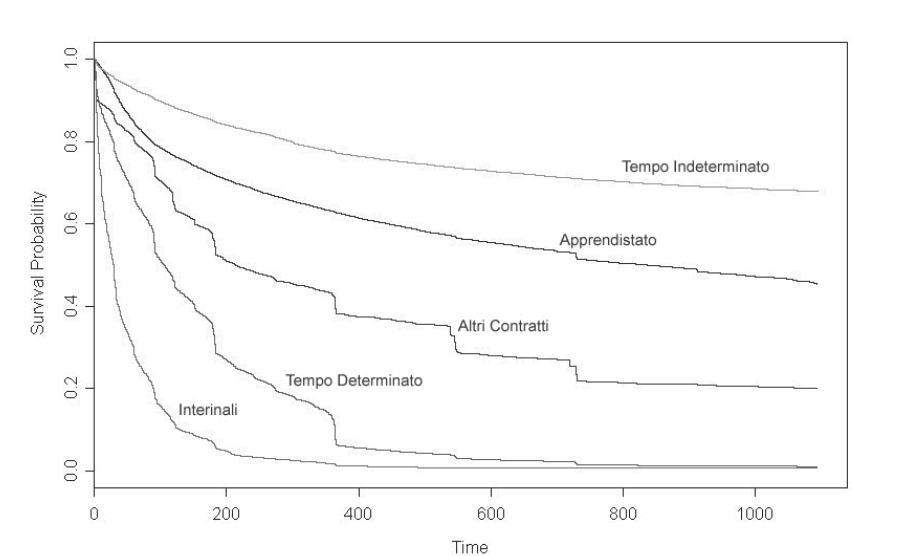
Figure 2 – Survival curves, according to contract type, for the province of Bologna (2004-2006). Source: Elaboration of SILER data – Province of